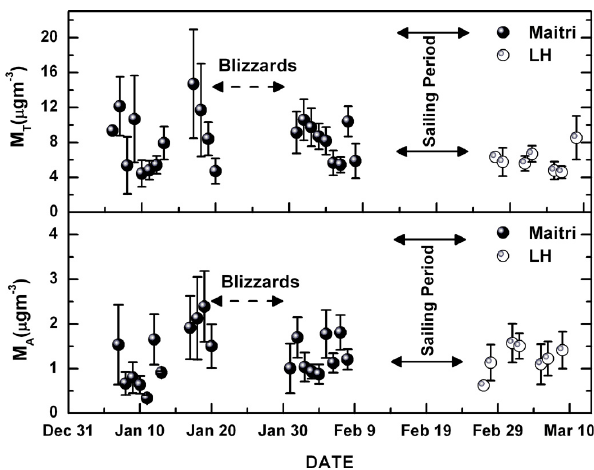
Fig. 7. Daily mean total mass concentration ( M T ) and accumulation mode mass concentration ( M A ) . The solid and open circles are daily averages of M T and M A for Maitri and LH in top and bottom panel, respectively. The vertical lines passing through the symbol are the standard deviations from the mean